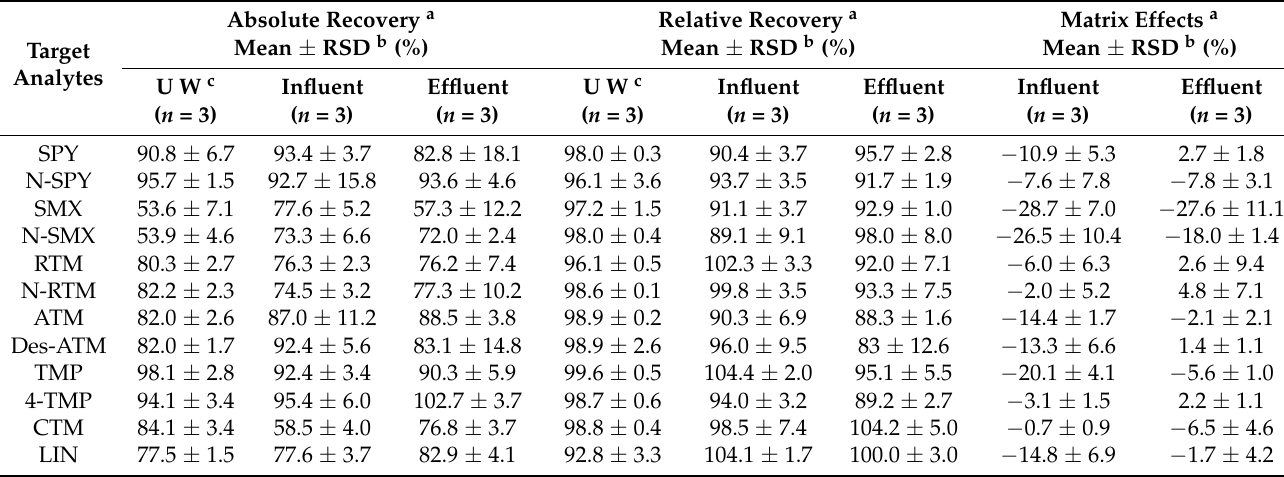
Table 2. Absolute and relative SPE recoveries of analytes in various environment samples using the PEP cartridge under extraction pH of 3.0, and matrix effects on analytical method